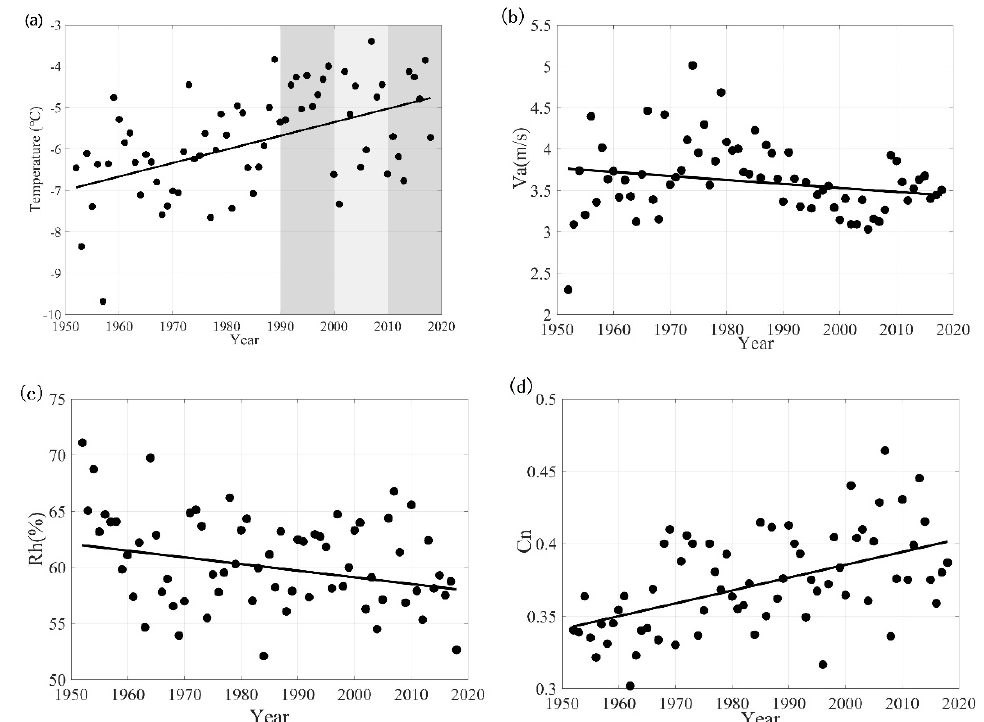
Figure 3. Multi-decadal (1950–2020) winter seasonal mean value of ( a ) air temperature, ( b ) wind speed, ( c ) relative humidity, and ( d ) total cloudiness. Each grey column marks one decade. The fitting lines were generated by using the Theil–Sen estimator. Table 2. Significance of trends (Mann–Kendall test) of meteorological parameters during the freez- ing season.